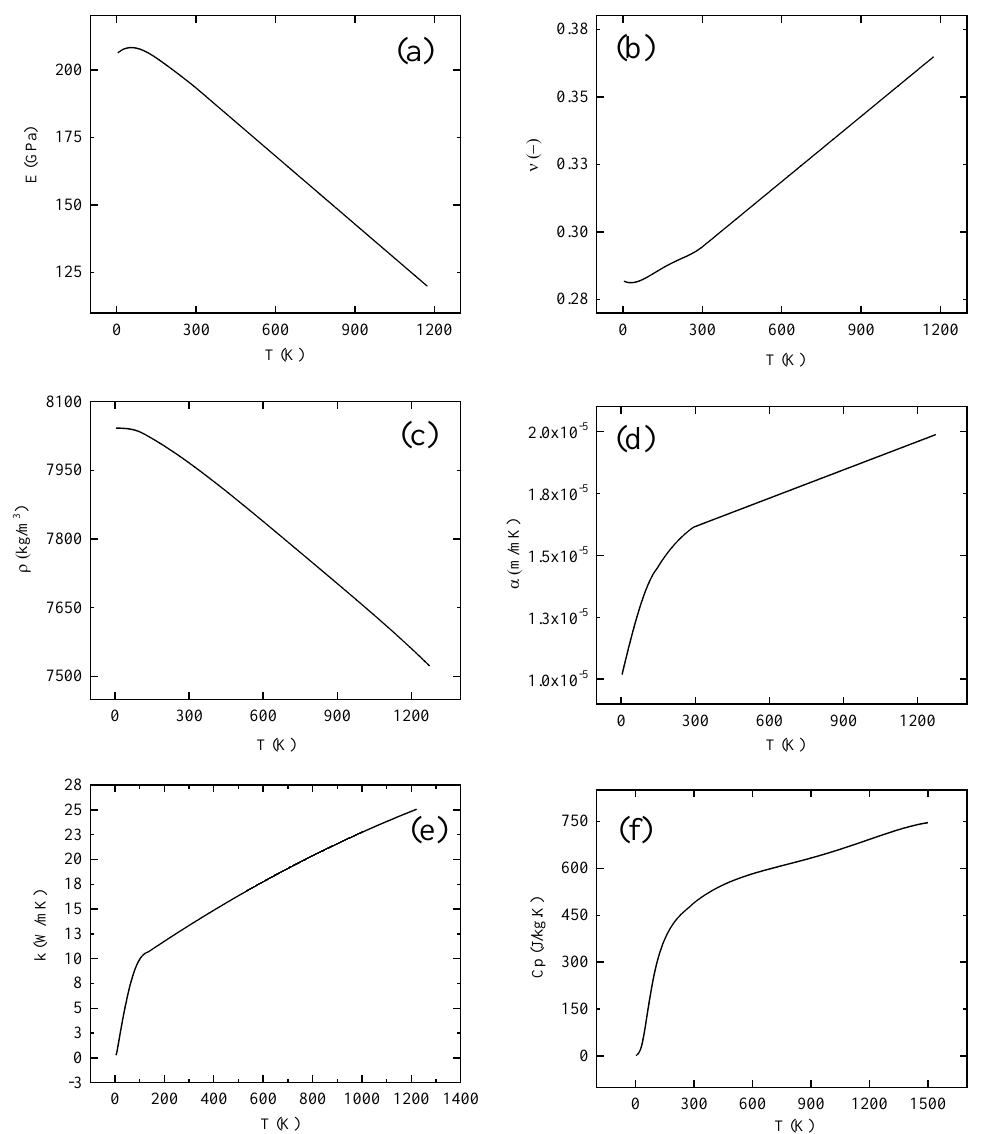
Figure 7. Material properties used in the simulation. ( a ) Young’s modulus; ( b ) Poisson’s ratio; ( c ) Density; ( d ) Thermal expansion coefficient; ( e ) Thermal conductivity; ( f ) Specific heat capacity.